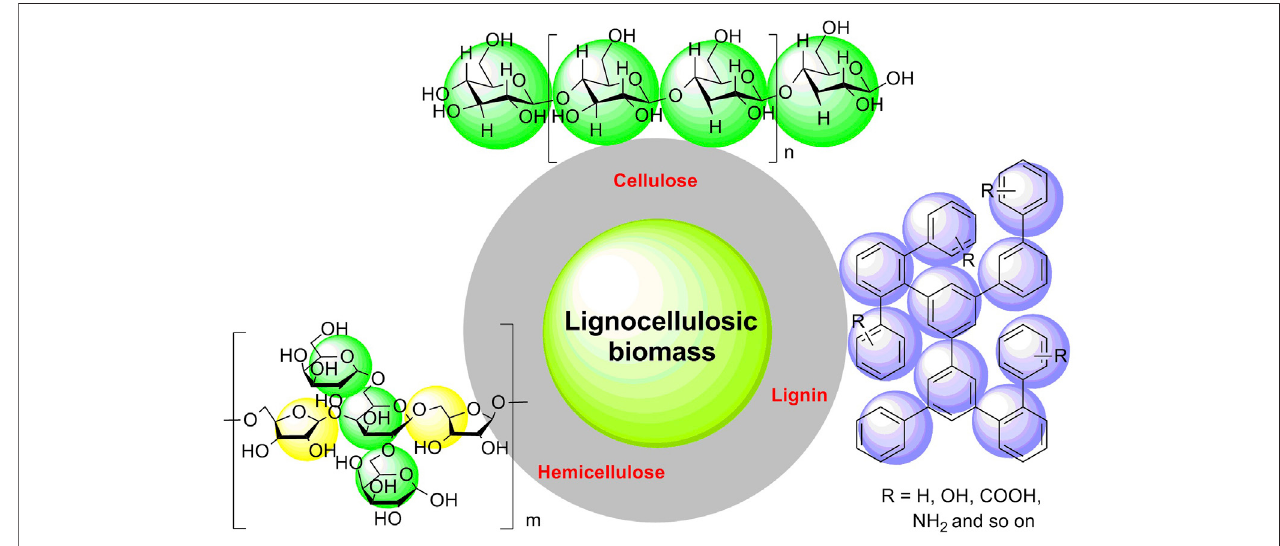
FIGURE 1 | Compositions of lignocellulosic